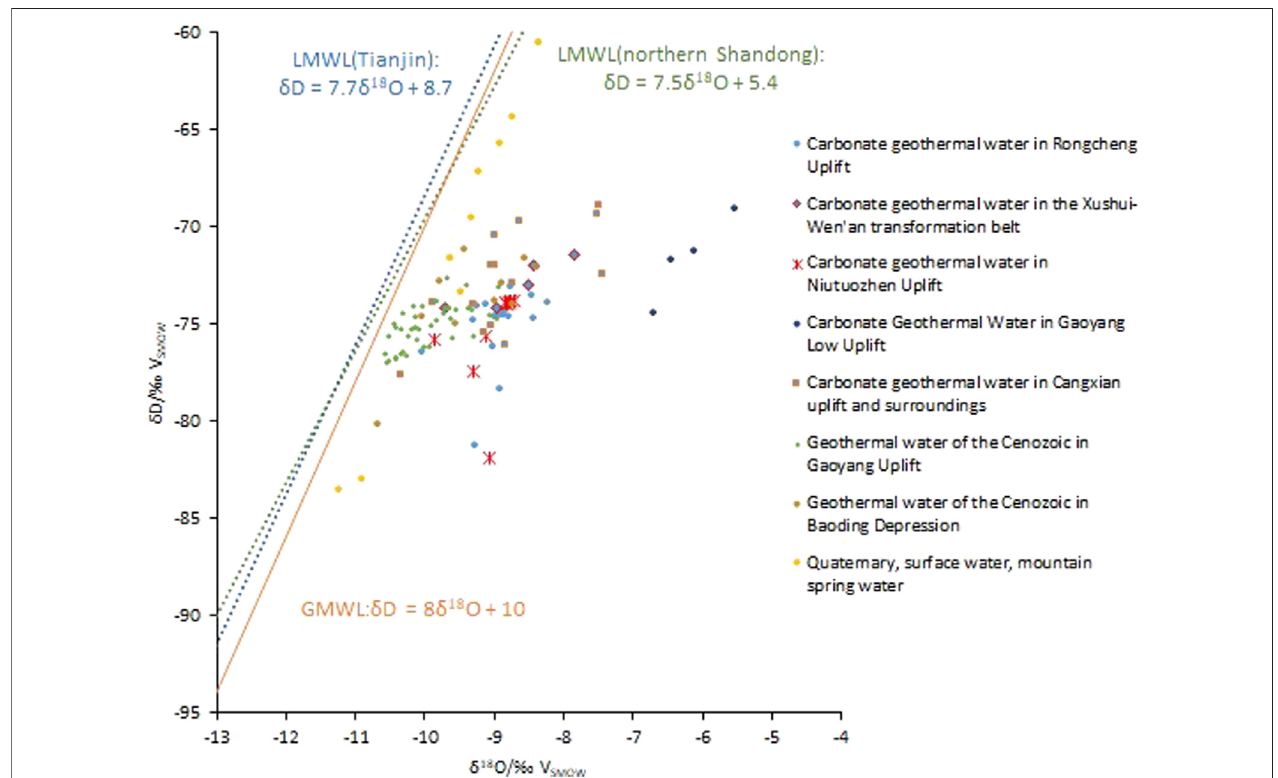
FIGURE 3 | Characteristics and relationship of δ D- δ 18 O of geothermal water in Xiong ’ an New Area and its surroundings.